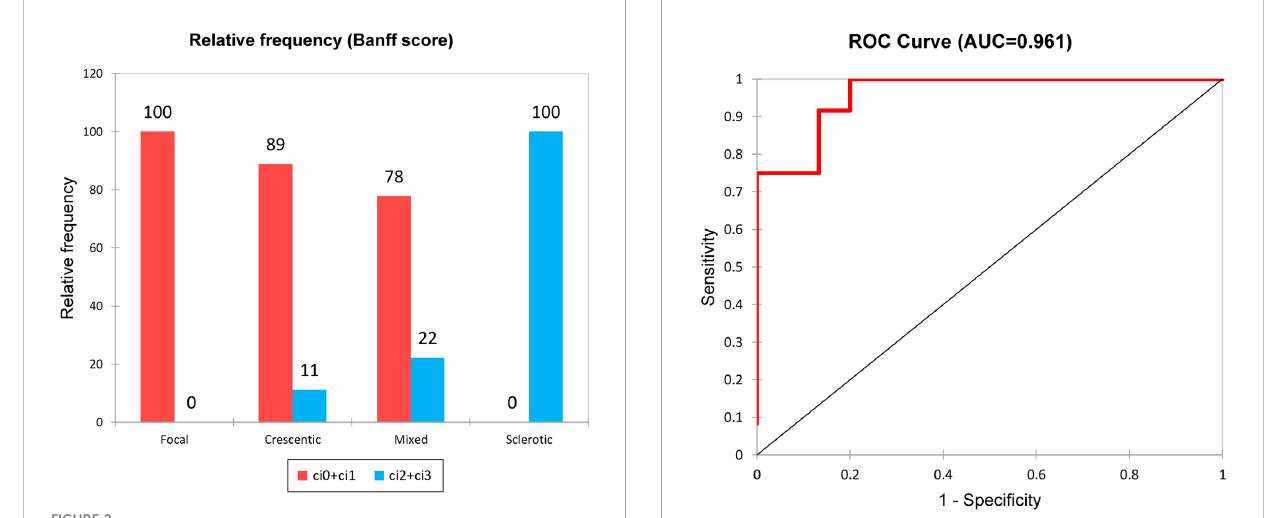
FIGURE 2 Extent of interstitial fi brosis in the different biopsy classes. According to Banff score: 1 – ci0+ci1; 2 – ci2+ci3.